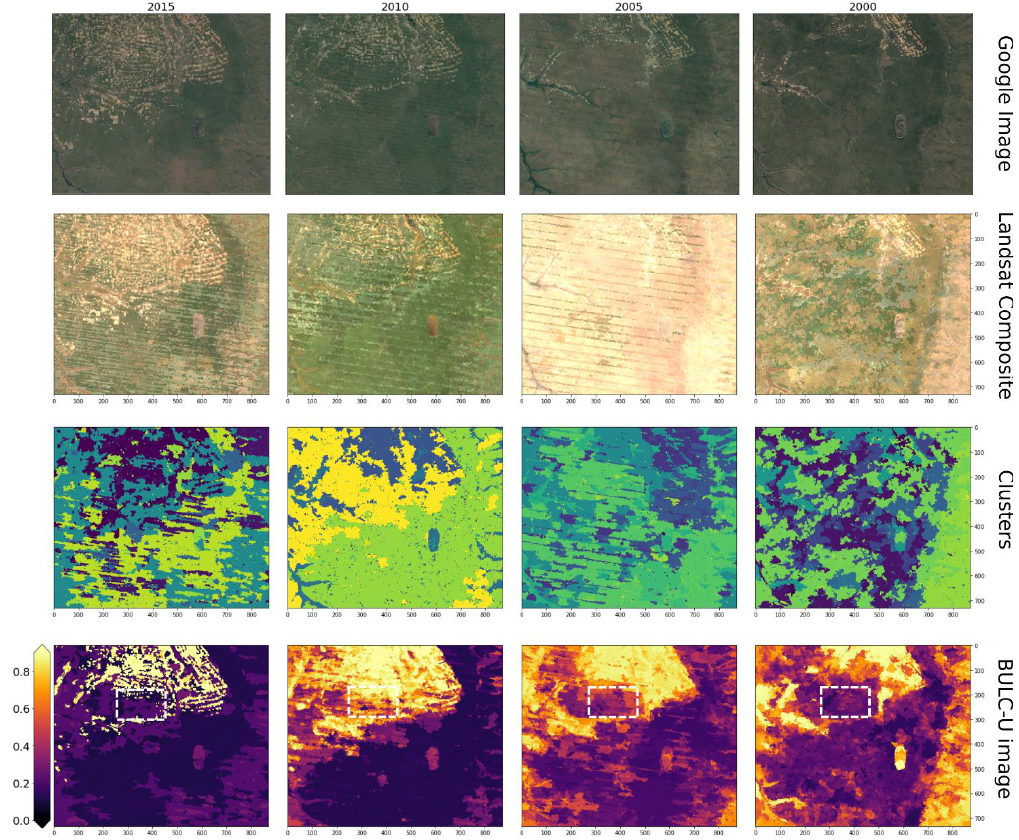
Figure 5. An example of the workflow output for four time points (2015, 2010, 2005, and 2000). For each time point, the Google image (top row, for reference), Landsat composites (second row), unsupervised classification with segmentation (third row), resulting cropland probabilities from the BULC-U algorithm (fourth row) are shown. The white locator box highlights high probability cropland that appears in 2010 and disappears in 2015, indicating a probable loss of cropland